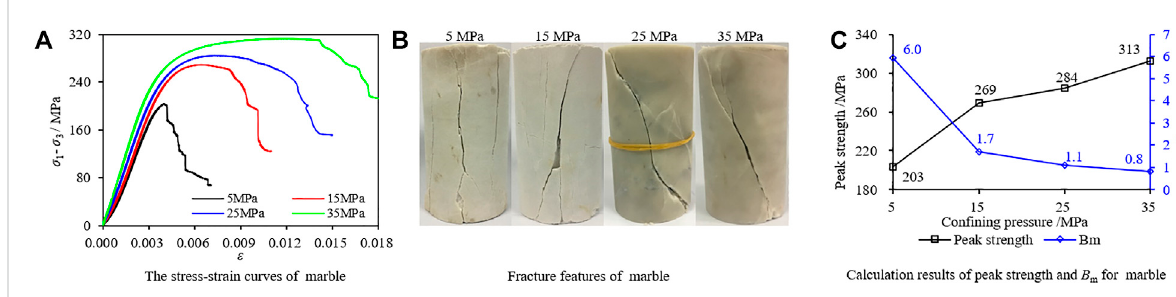
FIGURE 4 Test results and Bm values marble under different con fi ning